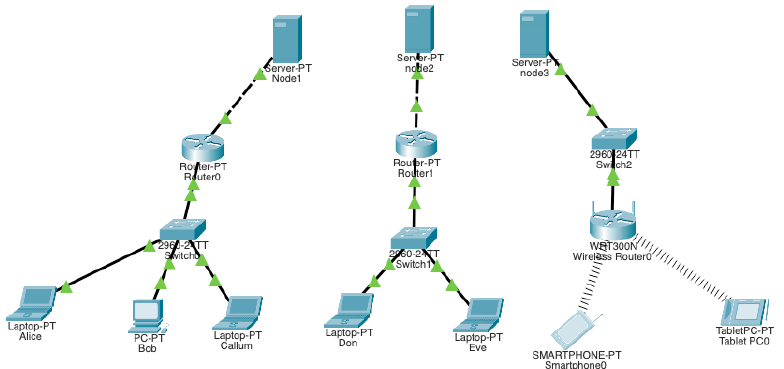
Figure 6. Simulation of the fog computing environment in the Cisco packet